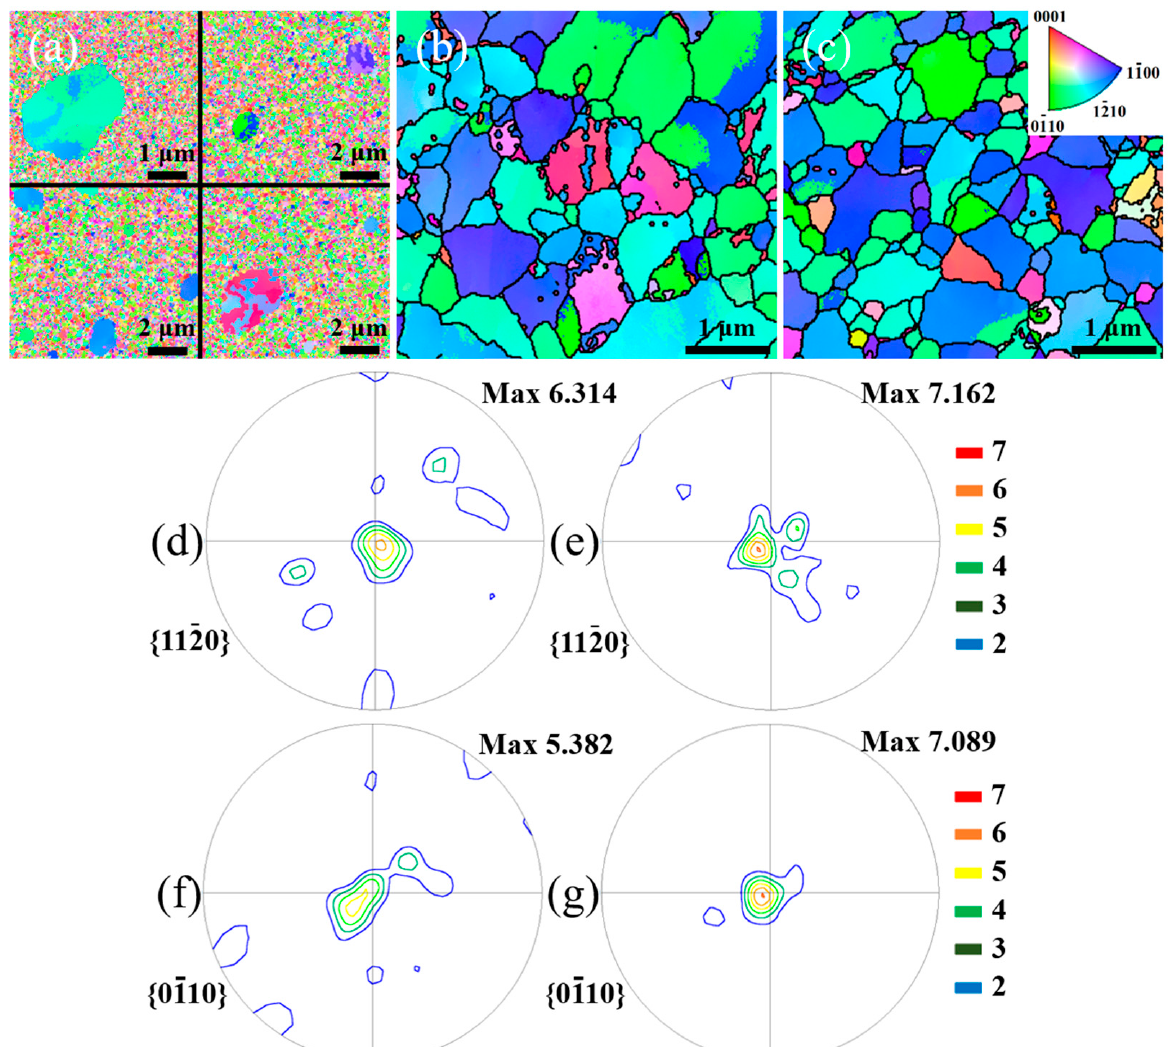
Figure 3. Orientation mapping images of Sb 2 Te thin films (200 nm) annealed at different temperatures: ( a ) 140 °C; ( b ) 200 °C; ( c ) 400 °C. The holding time is 30 min. Calculated (cid:4668)112(cid:3364)0(cid:4669) and (cid:4668)011(cid:3364)0(cid:4669) PFs counted from EBSD maps of Sb 2 Te thin films annealed at ( d , f ) 200 °C; ( e , g ) 400 °C. Panel ( a ) shows the four randomly captured crystallized regions. Different colors represent pole density levels: blue for 2, dark green for 3, light green for 4, yellow for 5, orange for 6, and red for 7. The maximum pole density is near the center of the calculated PFs.